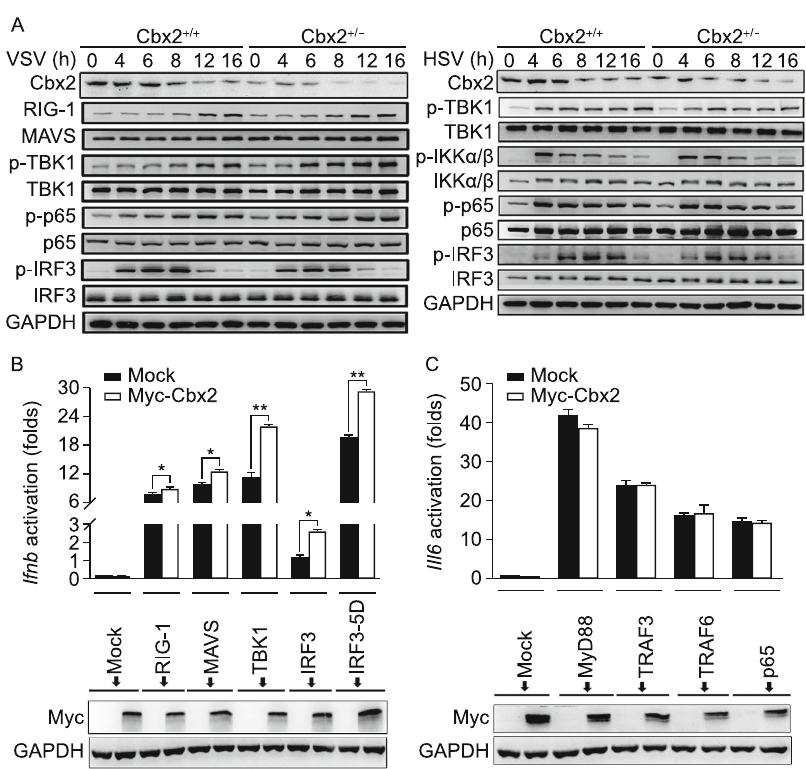
Figure 4. Cbx2 enhances IFN- β transcription. (A) Western blot analysis of mouse peritoneal macrophages derived from Cbx2 +/ − or Cbx2 +/+ mice after challenge with VSV or HSV (MOI = 10) for the indicated times. (B and C) Analysis of luciferase activity and myc- Cbx2 expression in lysates of HEK293T cells stably over-expressing IFN- β -Luc (B) or IL-6-Luc (C). Results were normalized by Renilla luciferase activity ( n = 6). All data are from three independent experiments (mean ± SEM of technical triplicates) (B). Data are representative of three independent experiments with similar results. * P < 0.05; ** P <